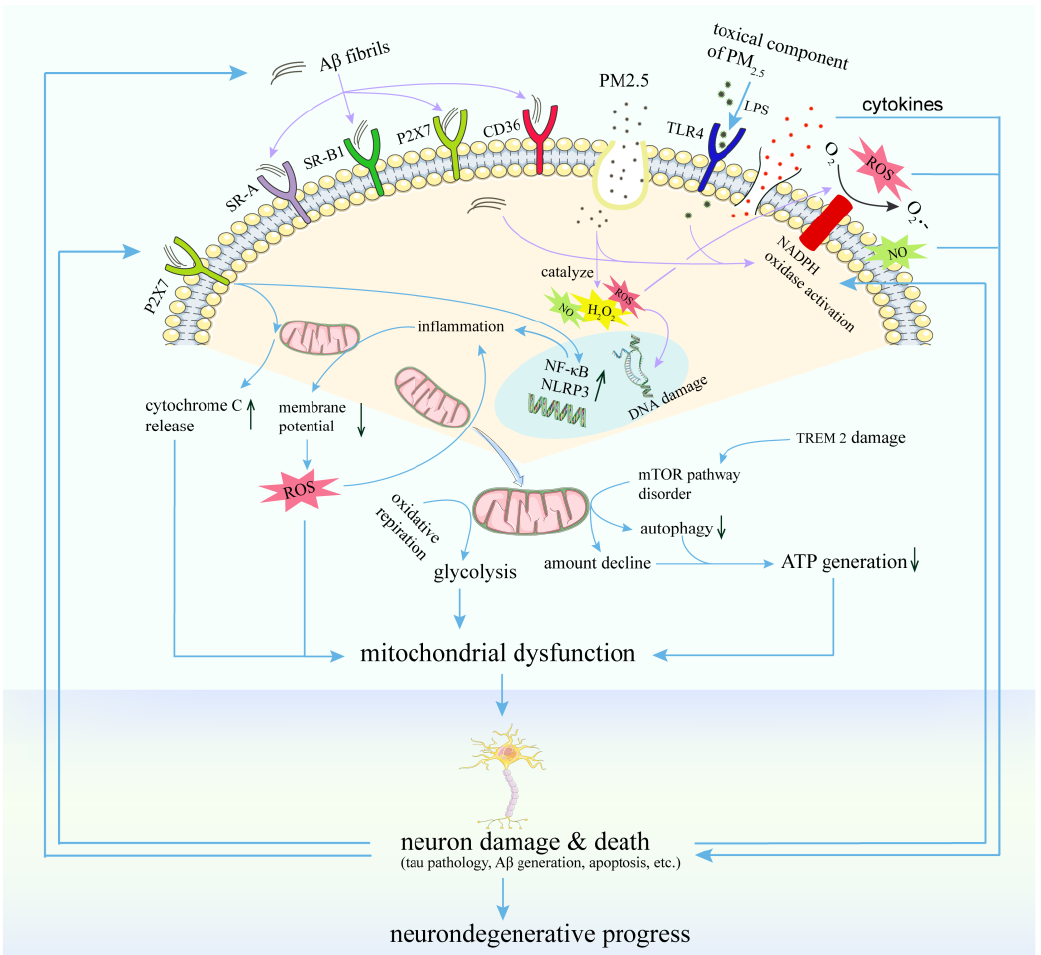
Figure 3. Proposed mechanisms for PRR-mediated microglia activation and neuronal toxicity induced by PM 2.5 . Microglia monitor the brain environment by interpreting and processing stimuli through pattern recognition receptors (PRRs), which mainly include TLRs, scavenger receptors, MAC1, and receptor complex for diverse neurotoxic and pro-inflammatory ligands, respectively. Exogenous and endogenous insults bind to diverse PPRs and result in microglial activation and release of soluble factors, such as cytokines, PGE2, and neurotrophins (BDNF), which bind to neuronal receptors. Meanwhile, neuronal metabolites and damaged neuron components could also activate microglia. Together, microglia-neuron interactions further promote the pathogenesis of neurodegenerative disorders.